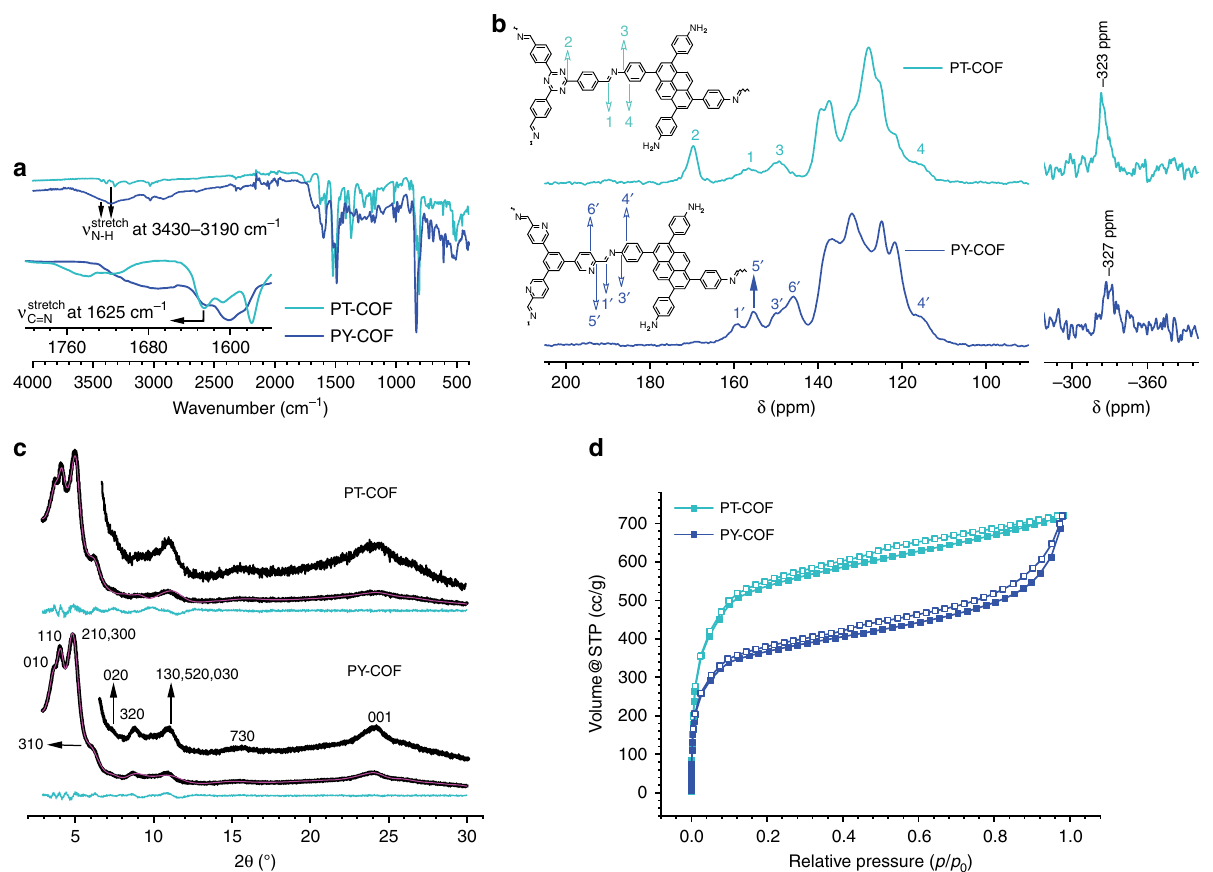
Fig. 3 Characterization of PT- and PY-COFs. a FT-IR characterization of PT- and PY-COFs. Free amine functionalities can be identi fi ed by the characteristic − 1 – 3190 cm − 1 . The inset shows the presence of ν ν 13 C ssNMR spectra with corresponding assignments. The N-H(stretch) in the region 3430 cm C = N(stretch). b unassigned signals correspond to the pyrene moiety and the phenyl rings. 15 N ssNMR depicting the free amine functionalities in PT- and PY-COFs is shown on the right as an inset. c PXRD patterns of PT- and PY-COFs with corresponding Rietveld re fi nements (magenta) showing good fi ts to the experimental data (black) with minimal differences. The turquoise traces show the difference between the experimental data and the re fi nement. The corresponding Miller indices of the identi fi able re fl ections are shown as well. d Argon sorption isotherms of PT- and PY-COFs at 87 K. Filled and open symbols represent the adsorption and the desorption branches,